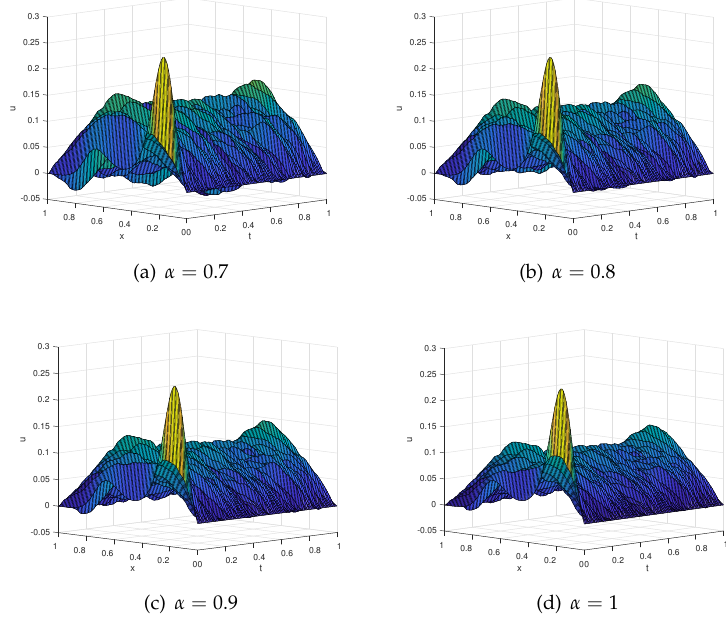
Figure 8. The approximation solutions of Example 2 (case (3)) with σ = 1.